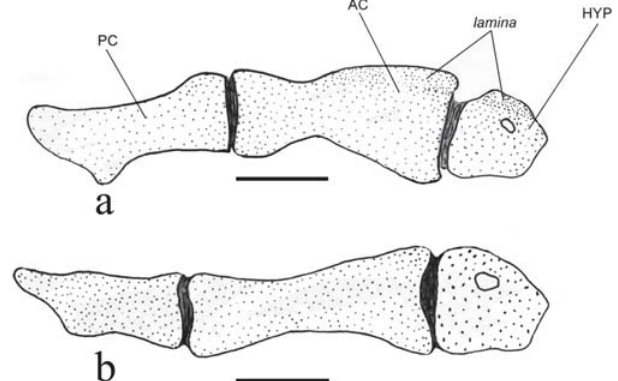
Fig. 4. Dorsal view of the hyoid bar of ( a ) Bunocephalus erondinae , paratype, MCP 33664 (68.5 mm SL) and of ( b ) B . doriae , MCP 13176 (50.9 mm SL). AC, anterior ceratohyal; HYP, hypohyal; and PC, posterior ceratohyal. Scale bar = 1 mm.